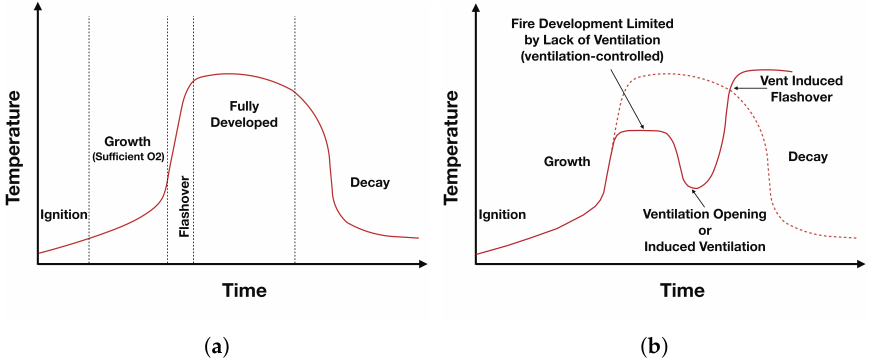
Figure 2. Flashover and ventilation induced flashover. ( a ) Flashover representation as a transition phase in the fire standard curve before the fully developed fire stage in an enclosure ( b ) Ventilation induced flashover